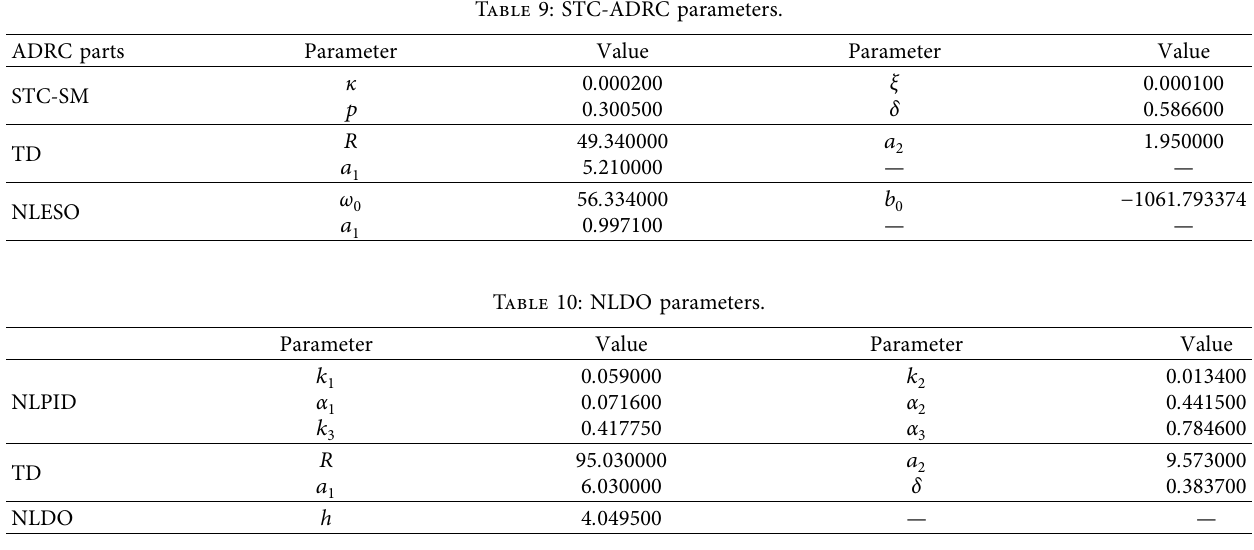
Table 9: STC-ADRC parameters.